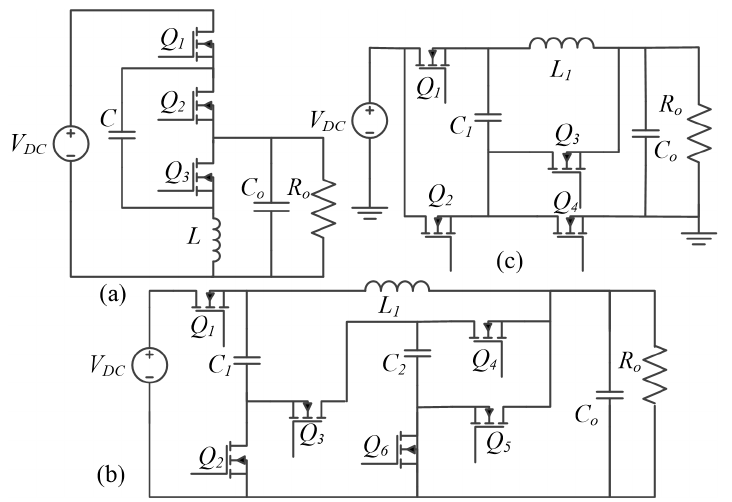
Figure 10. Dual-path hybrid converters; ( a ) output dual path, ( b ) always dual path and ( c ) input dual-path